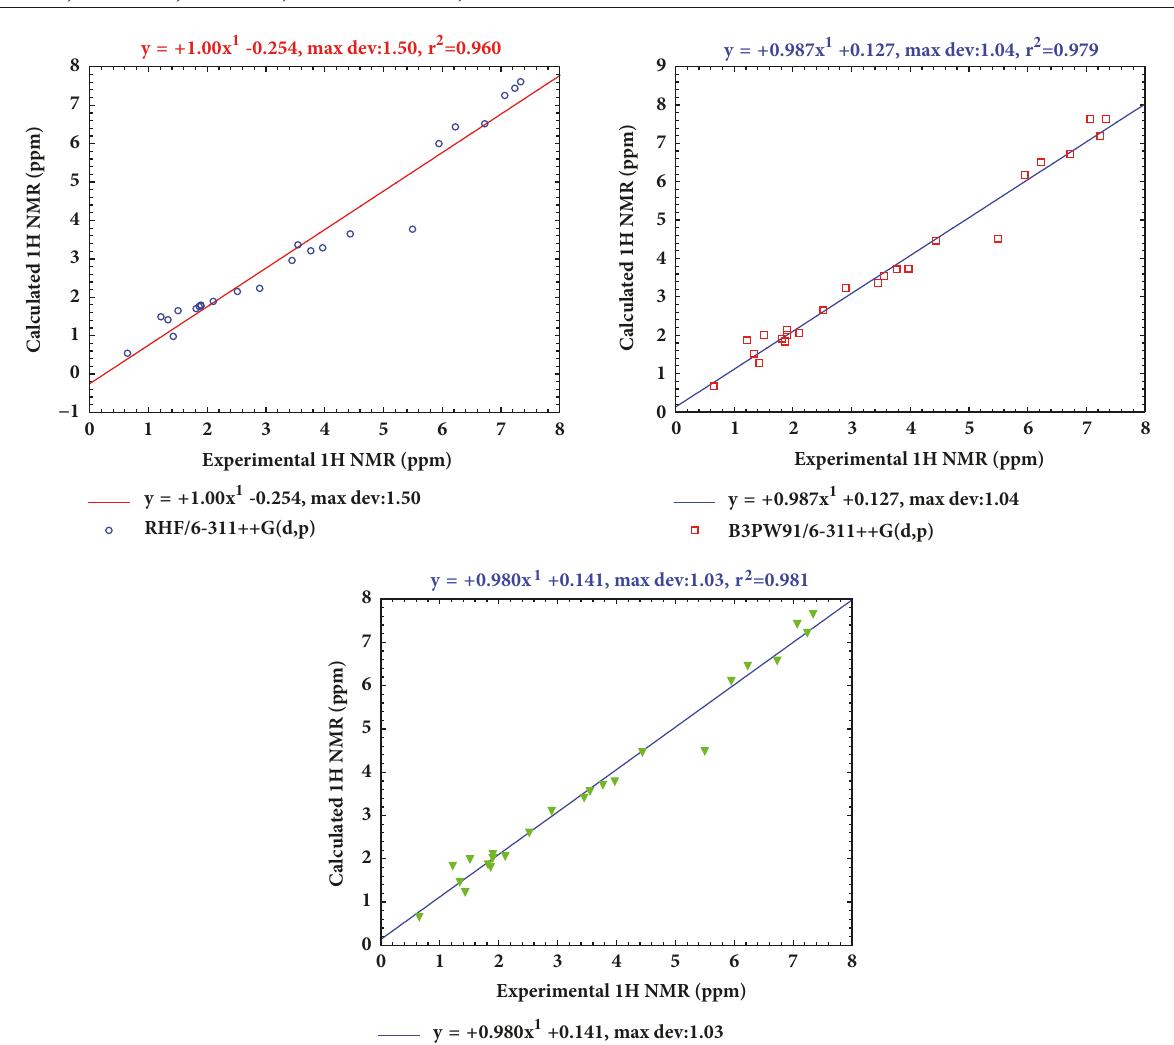
Figure 6: Comparison of experimental and theoretical 1 H chemical shifts of Rubescin E calculated at the RHF, B3PW91, and B3LYP using the 6-311++G(d,p) basis set in